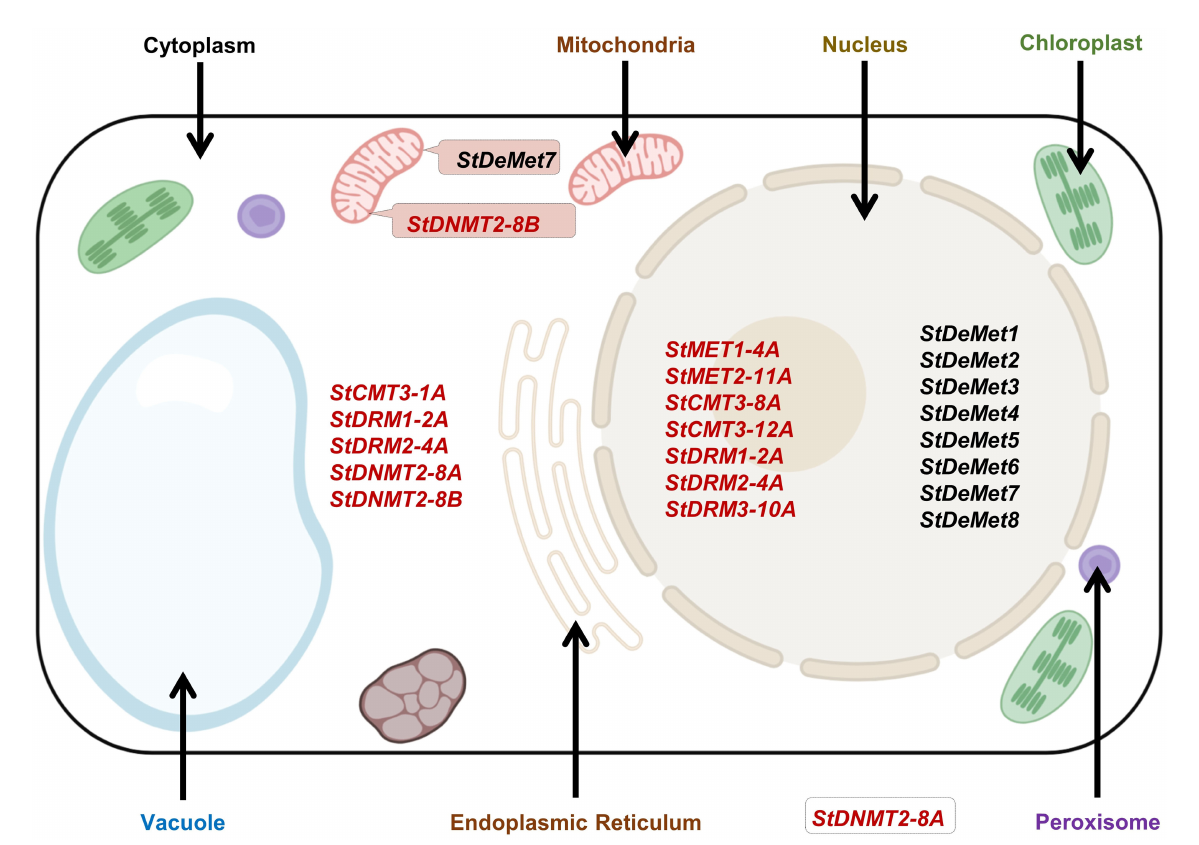
FIGURE4 Subcellular localization of StC5-MTase and StDeMet proteins in potato predicted using the CELLO program. Partially adapted from Gahlaut et al.